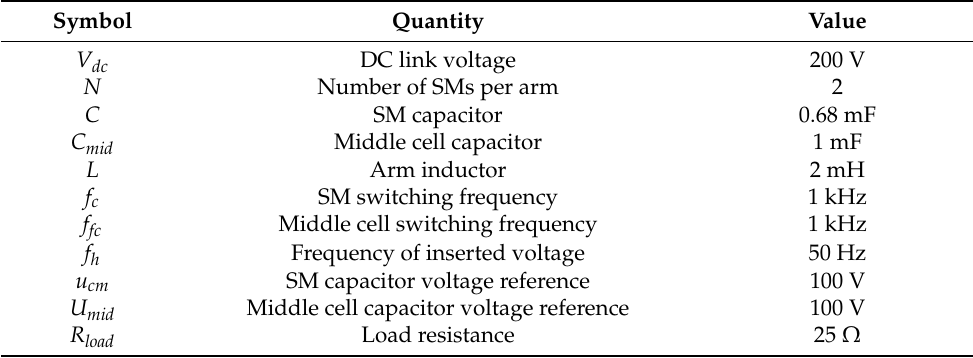
Figure 16. Experimental photograph of the proposed DC-DC MMC.